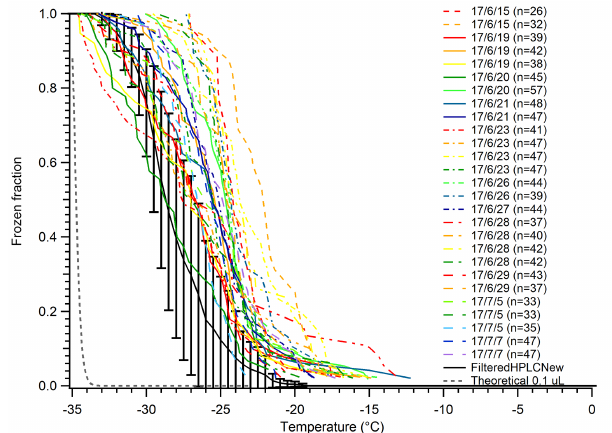
Figure 4. A series of tests on MilliQ-generated water droplets to determine contamination sources. Droplets displayed inexplicably high freezing temperatures compared to filtered HPLC water at the time (solid brown with error bars). Temperatures for N 50 ranged from − 20 to − 29 ◦ C from day to day. Error bars indicate stan- dard deviation of data for the filtered HPLC water. The gray dashed line indicates the theoretical homogeneous freezing curve of 0.1µL droplets, using the parameterization of Koop and Murray